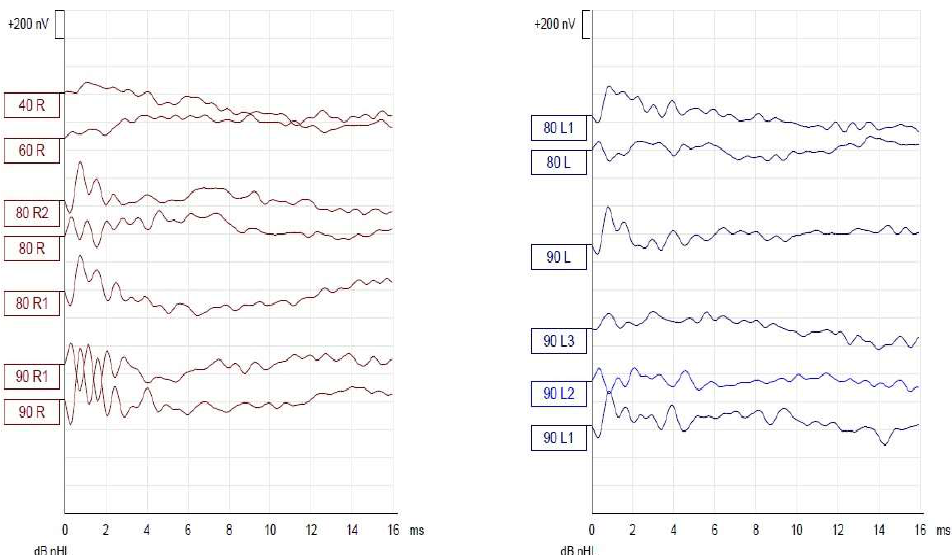
Figure 2. Auditory Evoked Potentials results for Case 1. Cochlear microphonic potentials to be observed bilaterally.